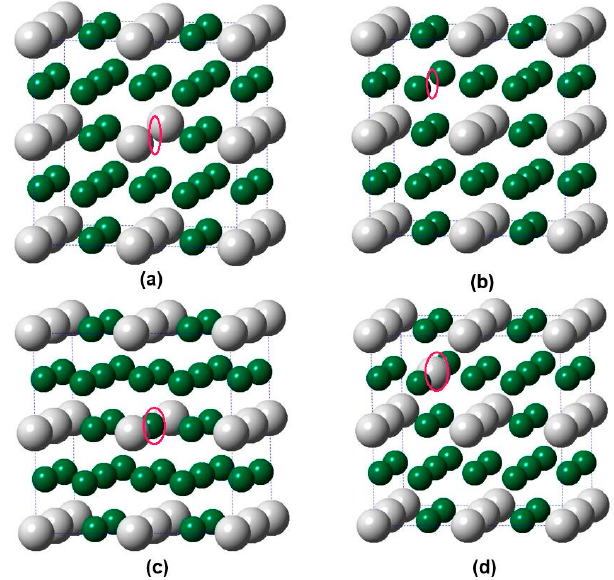
Figure 3. Schematic illustrations of defective supercells (2 × 2 × 2) of L1 2 Pd 3 Ag containing a single point defect, ( a ) Ag vacancy (V Ag ), ( b ) Pd vacancy (V Pd ), ( c ) Ag anti-site (Ag Pd ), and ( d ) Pd anti-site (Pd Ag ). The big white and small green balls represent Ag and Pd atoms, respectively.